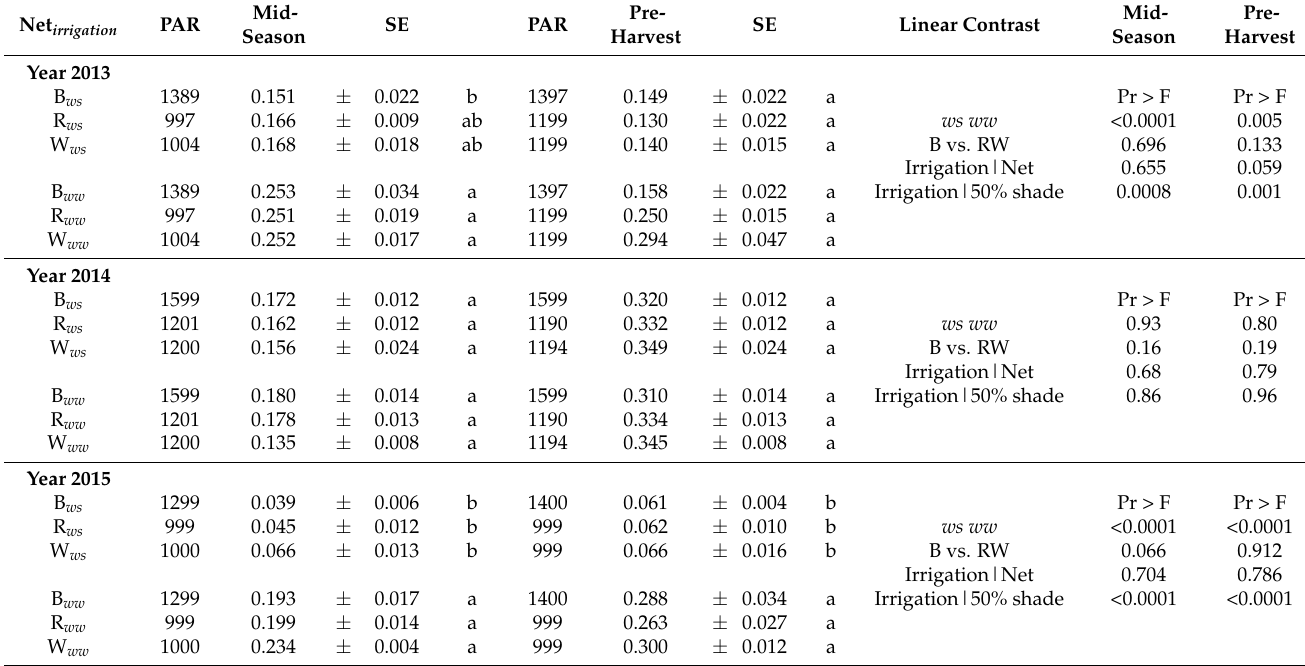
Table 3. Midday stomatal conductance values in two periods of the season (mid-season and pre-harvest) for net irrigation during the years 2013, 2014, and 2015. The interaction between treatments and crop load was not found to be significant, thus each value is the result of a simple ANOVA (mean of 4 trees). PAR values are reported and means are followed by standard error. The presence of different letters indicates significant differences at 95%, according to an SNK test. On the right side of the table, linear contrast F values for the two analyzed periods are shown; values below 0.05 are considered significant.